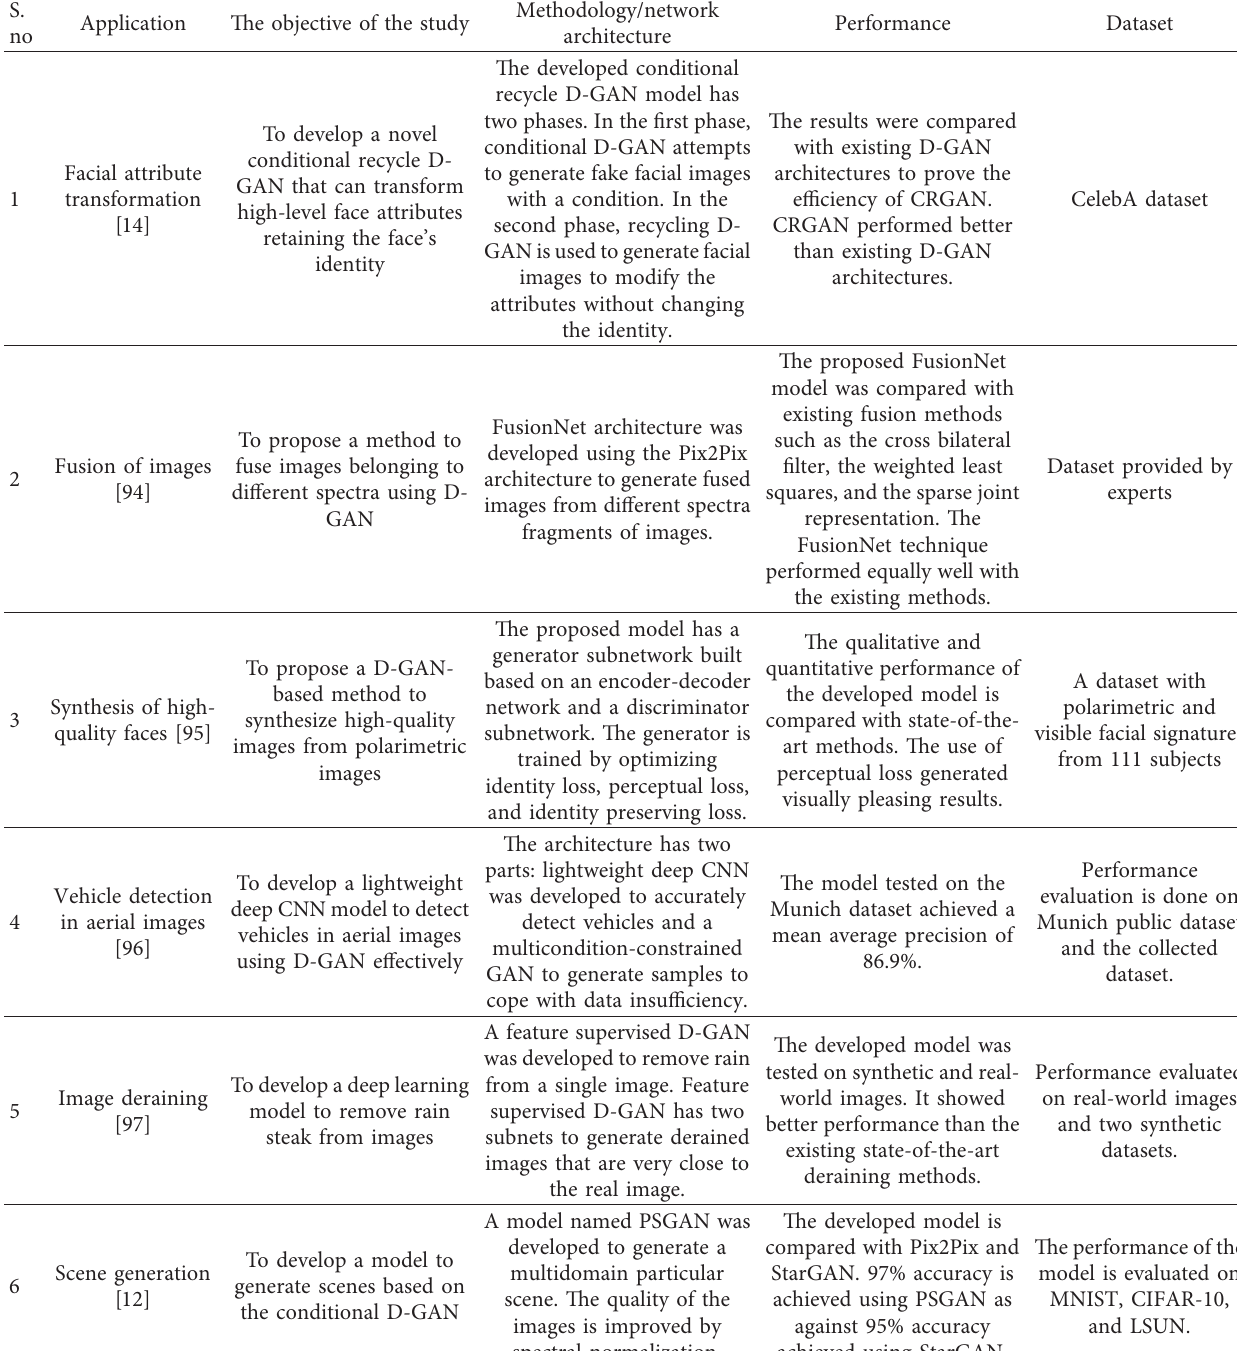
Table 6: Recent advancements of the deep GAN in computer vision.